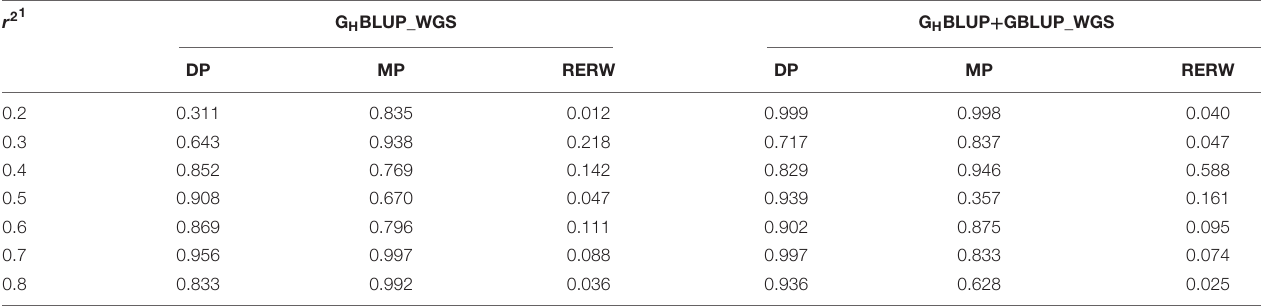
TABLE 5 | P -values of Hotelling’s t -test comparing the prediction accuracy obtained with the individual SNP and haploblock approaches using WGS data.